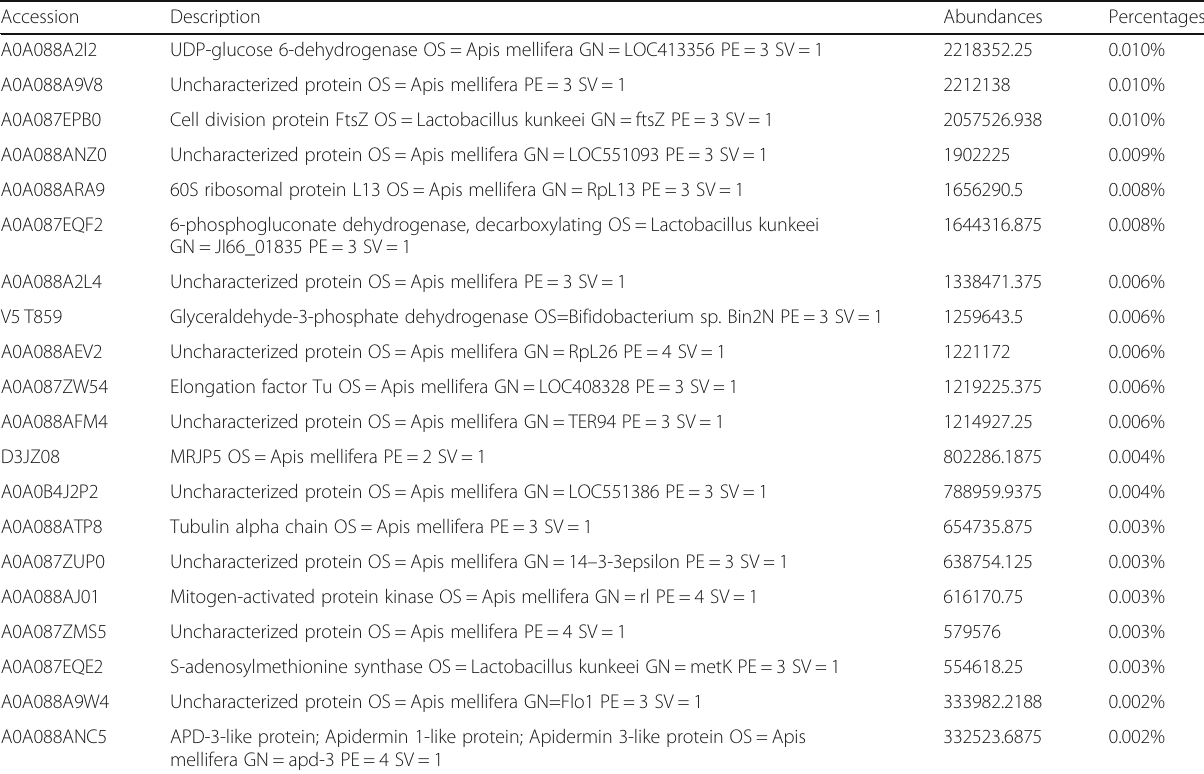
Table 1 Identification and quantification of proteins in Fraction 2